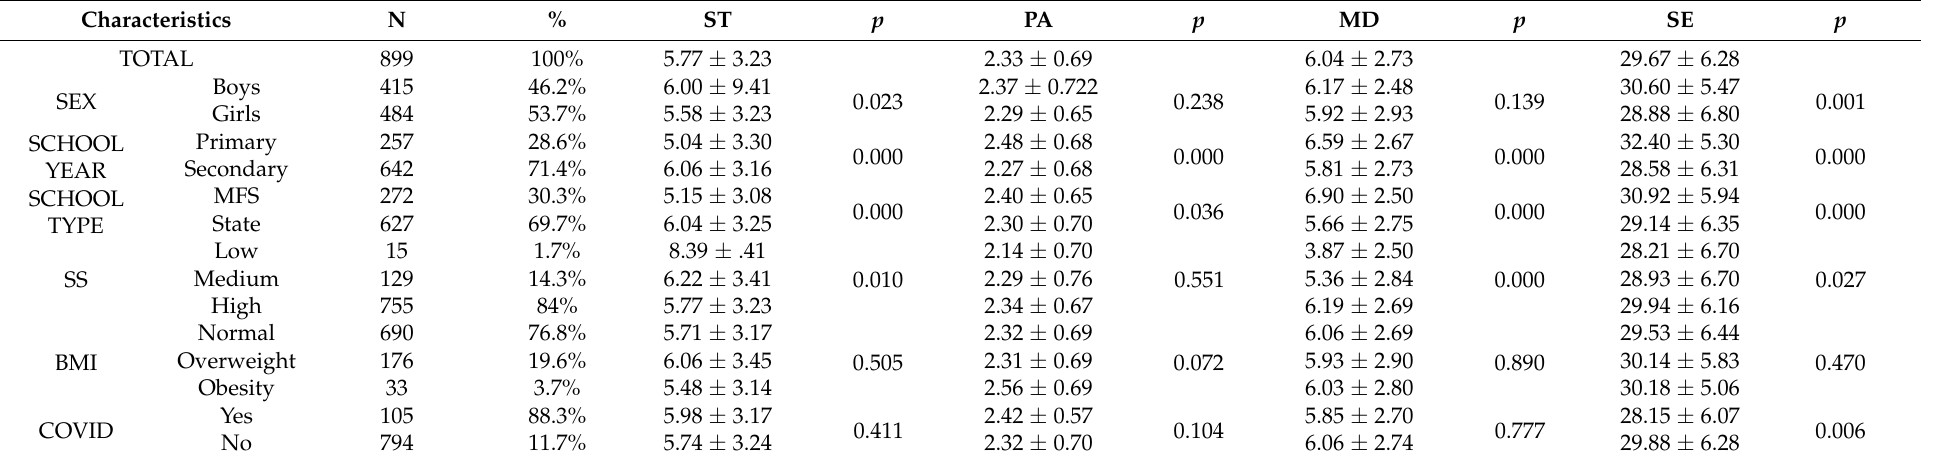
Table 1. Sample characteristics during the period of total confinement, according to sex, school year, school type, socioeconomic status, BMI and whether or not they had been infected with COVID-19.